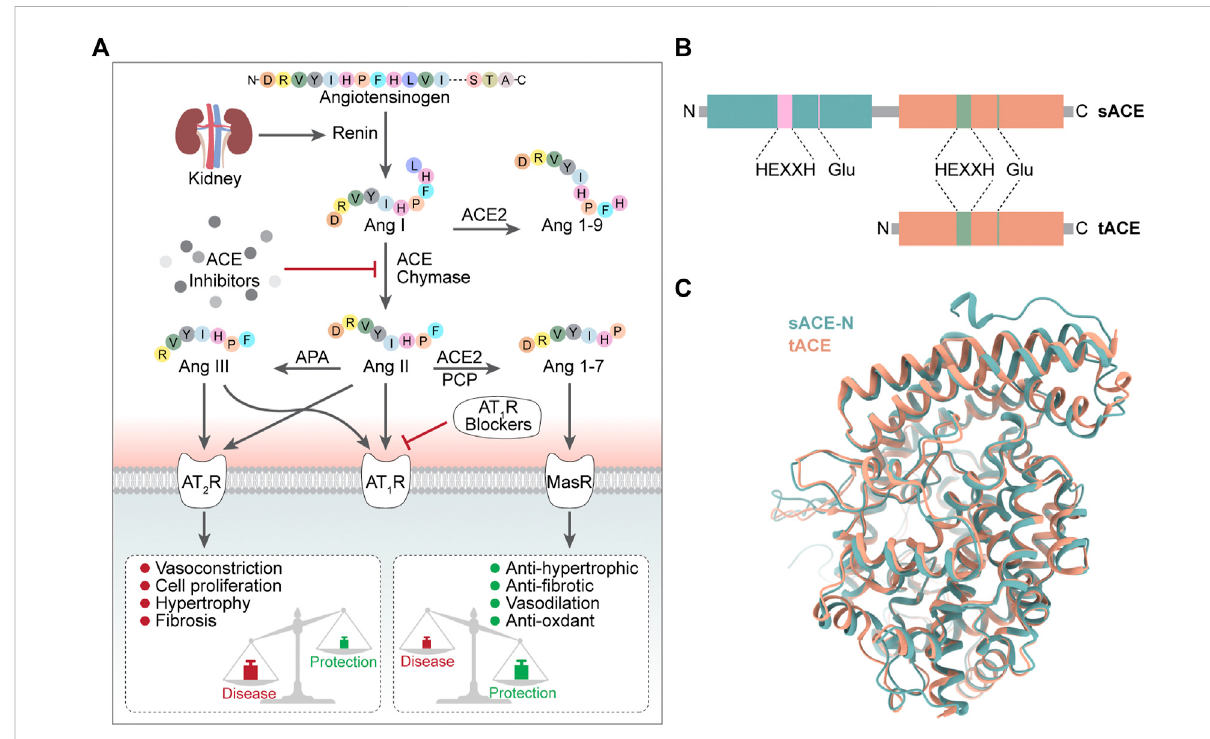
FIGURE 1 (A) Conversionprocessandbiology function ofACE (B) DomainstructureofsACEandtACE (C) 3DstructureofsACEsACE-Nisingreen.sACE- C (tACE) is in